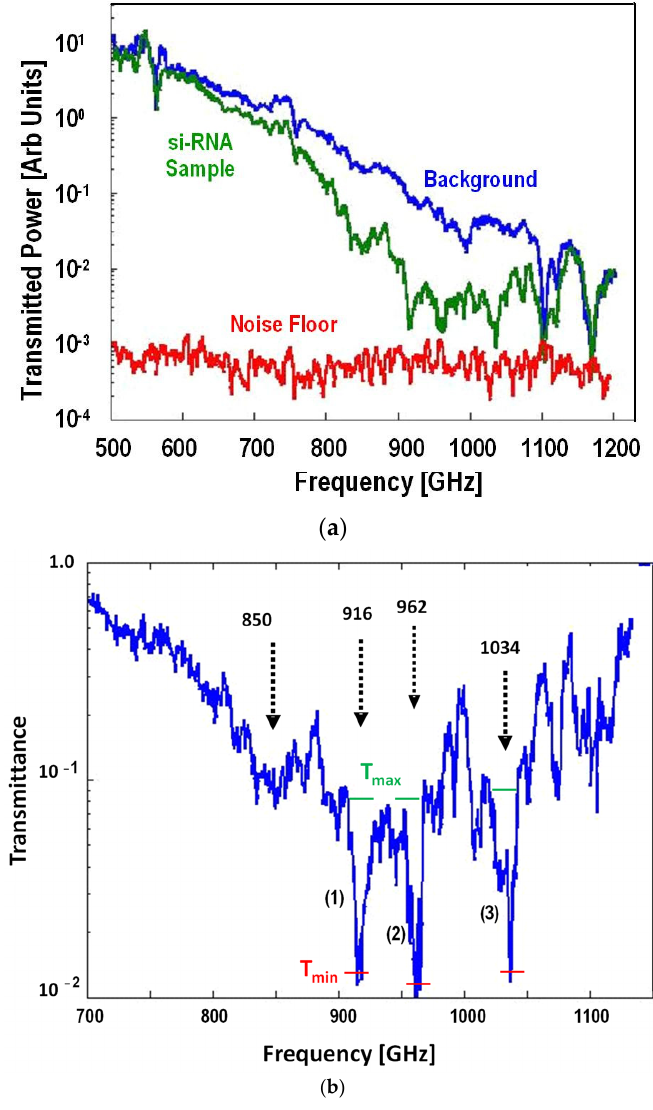
Figure 4. ( a ) Power spectra for background, sample, and noise floor for si-RNA solution in the nanochannel cell. ( b ) Transmittance using the raw data in ( a ) and computation with Equation (1). The prominent three signatures are labelled (1), (2), and (3).